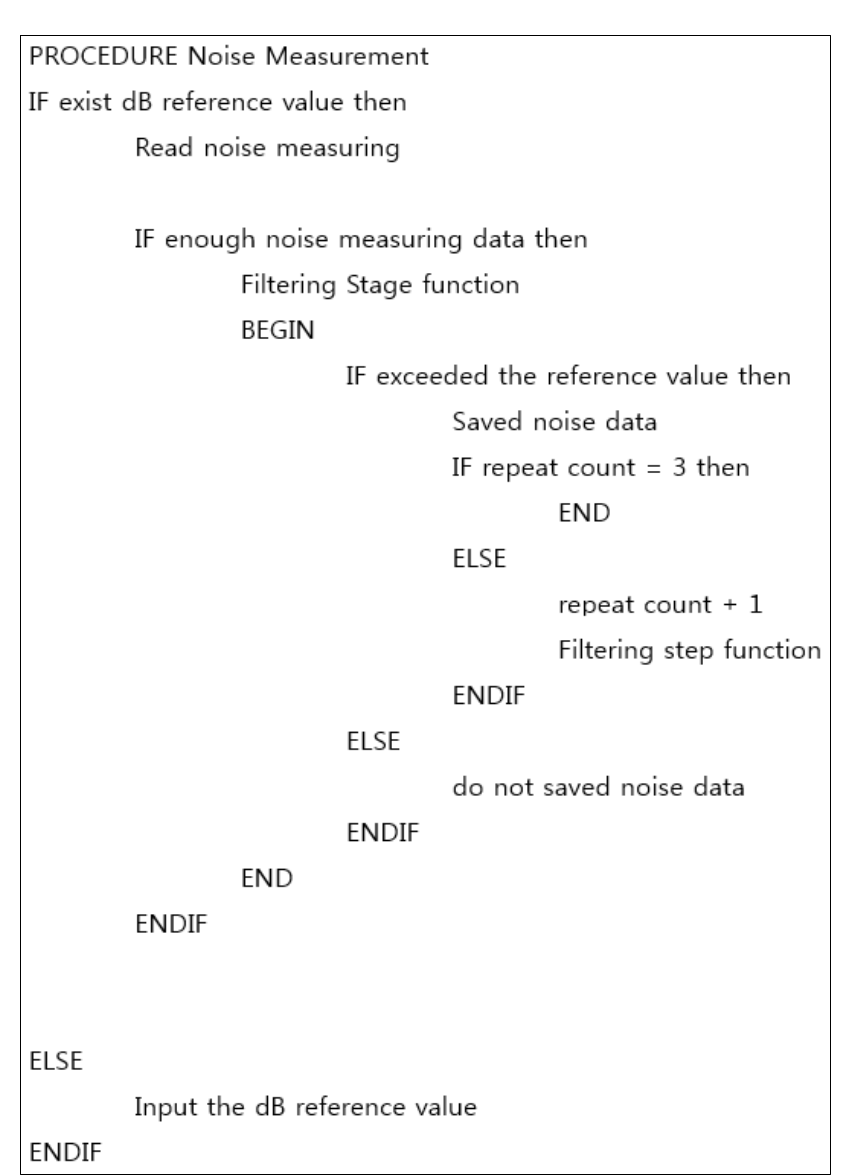
Figure 6. Algorithm for inter-floor noise measurement and evidence collection .